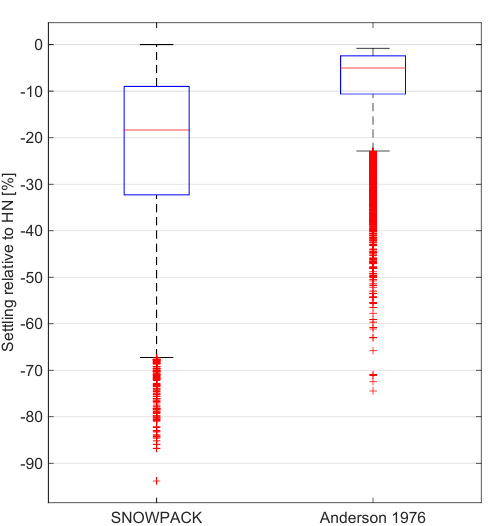
Figure 3. Box plots (median, 25 and 75% percentiles, 1.5 × interquartile ranges, outliers) of settling relative to hourly new snow heights (HN) modelled with SNOWPACK and using the ap- proach presented by Anderson